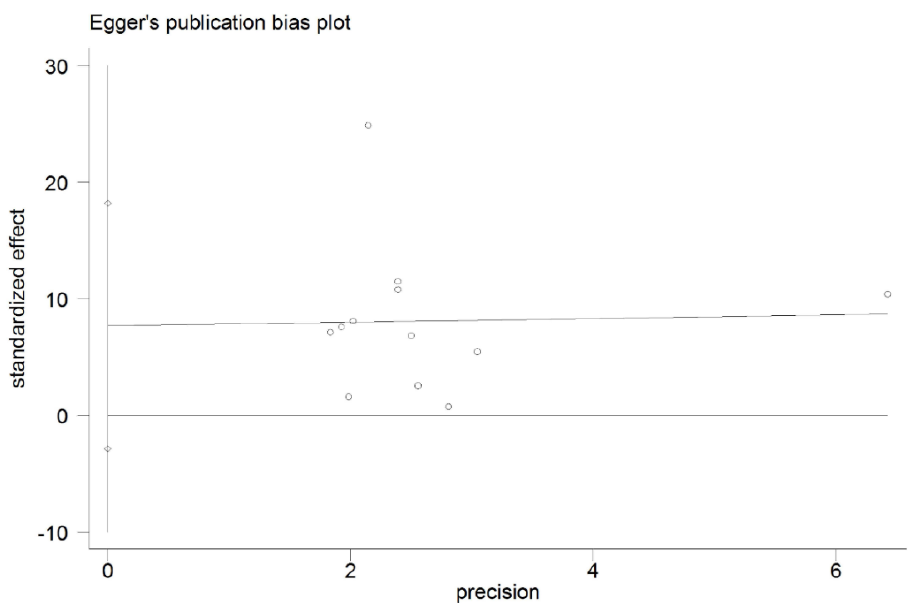
Figure 6. Forest plot of the studies comparing the association between vitamin D deficiency and Graves’ disease by meta-analysis with the random effects analysis. OR, odds ratio.